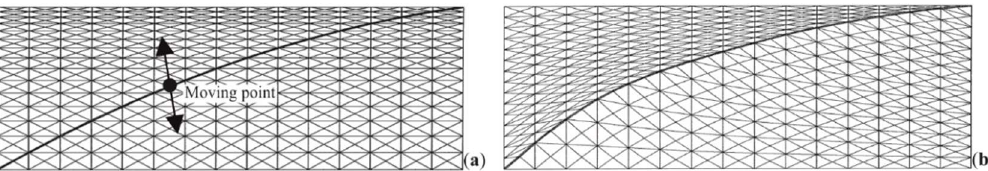
Figure 7. Part of the initial finite element mesh at the boundary of the magnetic pole ( a ); final step in the mesh formation ( b ).